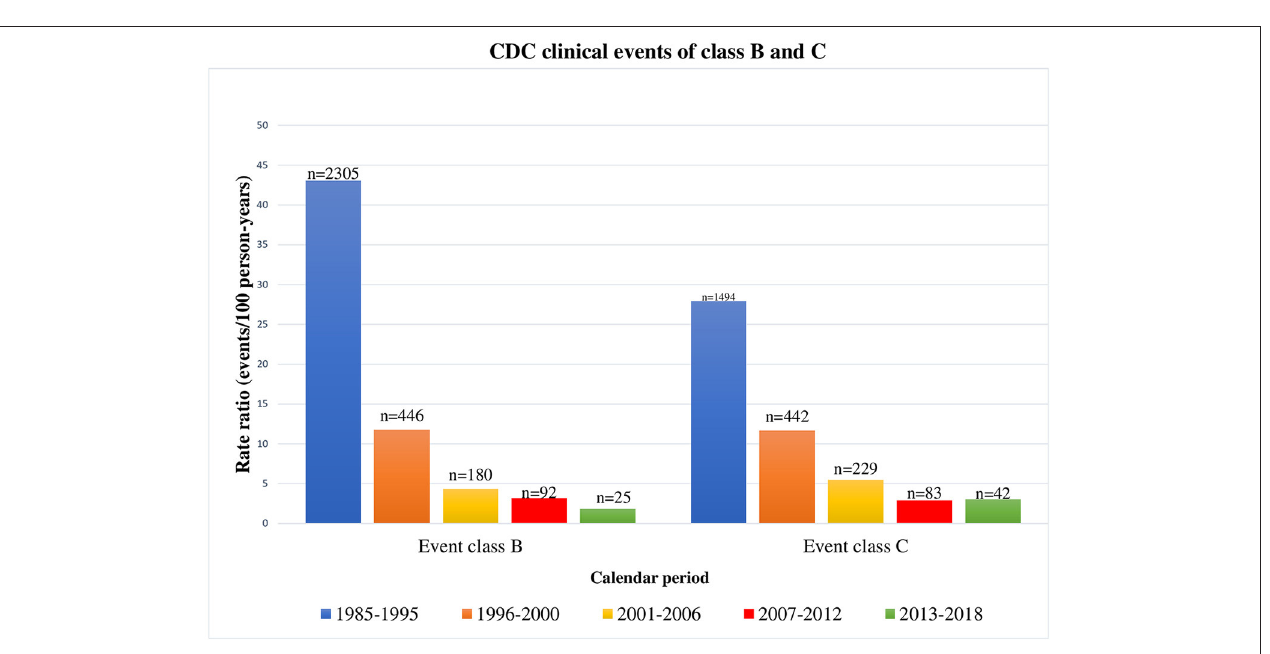
FIGURE 4 | CDC clinical events of class B and C occurred in HIV-1 infected children by calendar period, from 1985 to 2018 [1985–1995 and 1996–2000 periods refer to our previous results